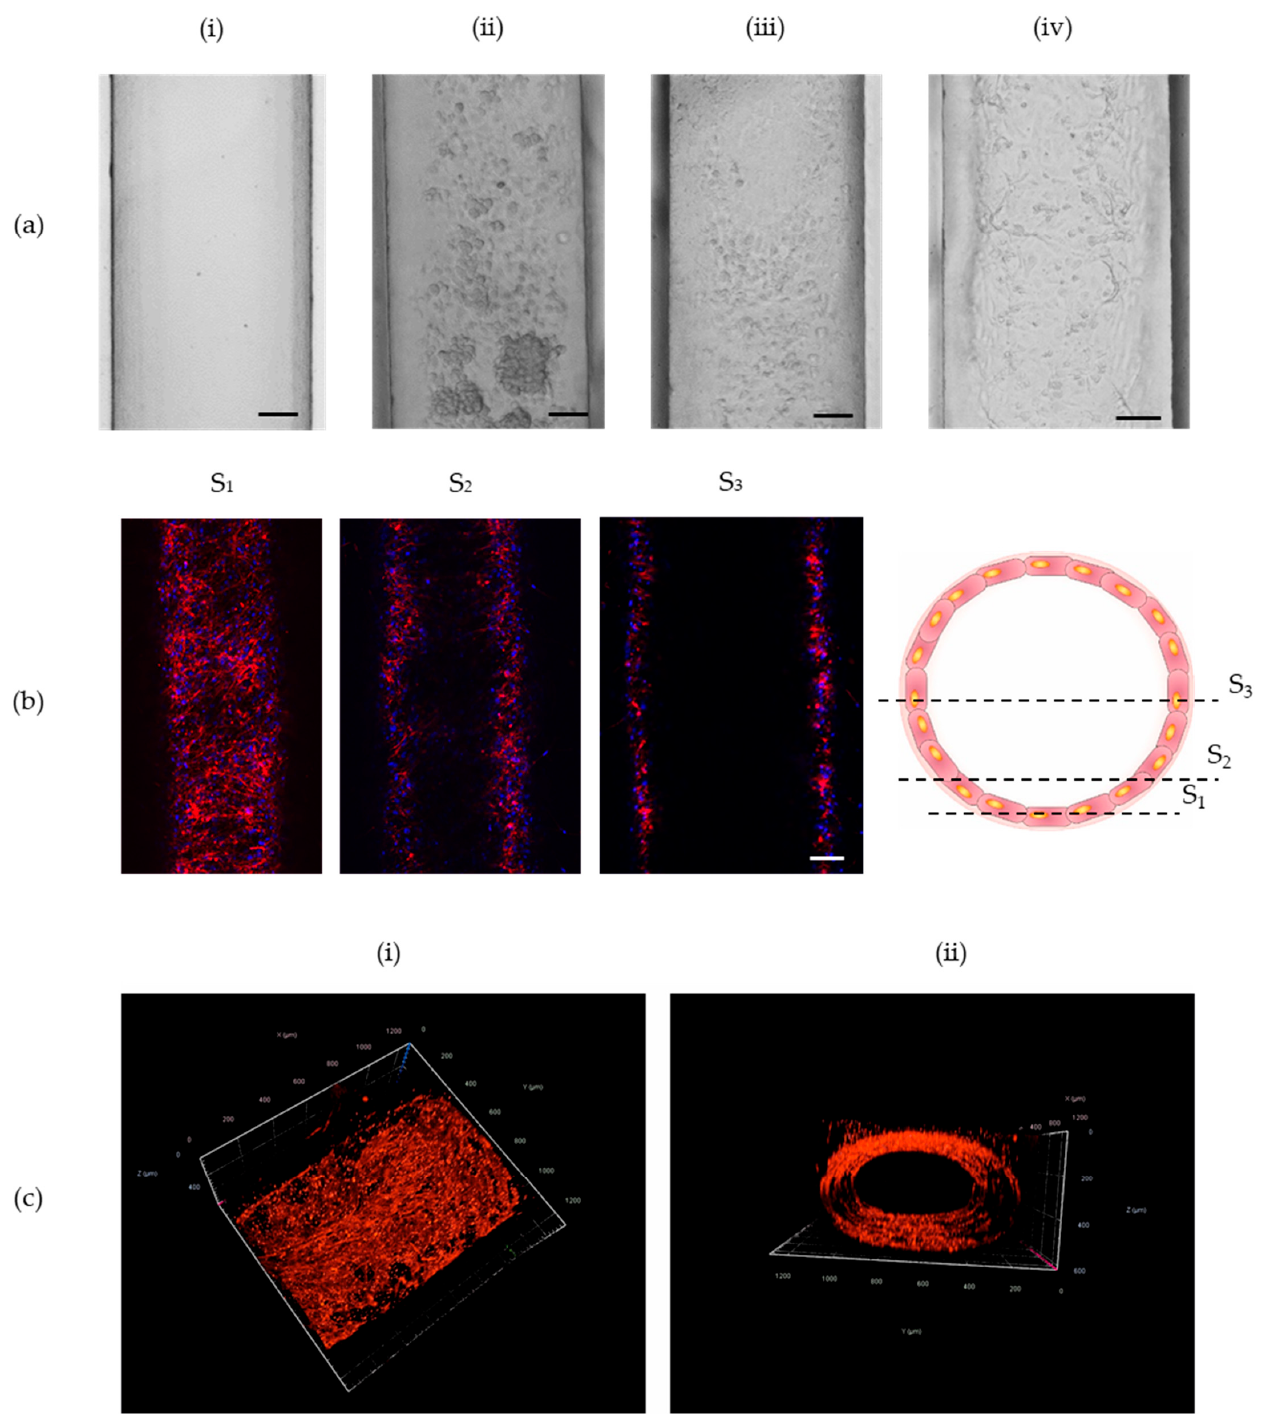
Figure 3. Structure of microvessel created by Viscous Finger Patterning. ( a ) Images present respec- tively cross-section of a microchannel ( i ) before cell’s loading ( ii ) seeded with 2 · 10 7 of HUVEC cells and constantly rotated for 2 h by 360 ◦ , ( iii ) seeded with 2 · 10 7 of HUVEC cells and rotated every 15 min by 90 ◦ ( iv ) seeded twice with 10 7 of HUVEC cells and rotated only once by 180 ◦ after the second loading of cells. Scale bar: 100 µ m ( b ) Chosen frames from z-stack image. Cells were stained with the use of phalloidin and Hoechst. Scale bar: 100 µ m ( c ) 3D structure of created microvessel: ( i ) top view, ( ii ) front